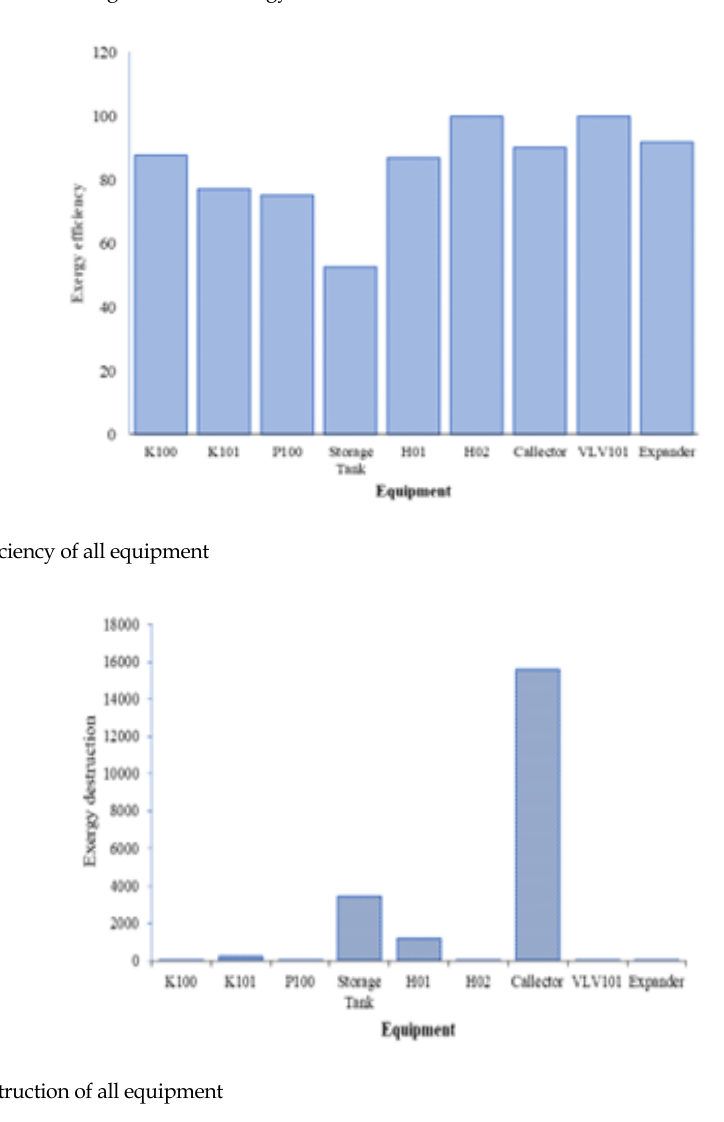
Figure 3. Flowchart of calculating the current exergy